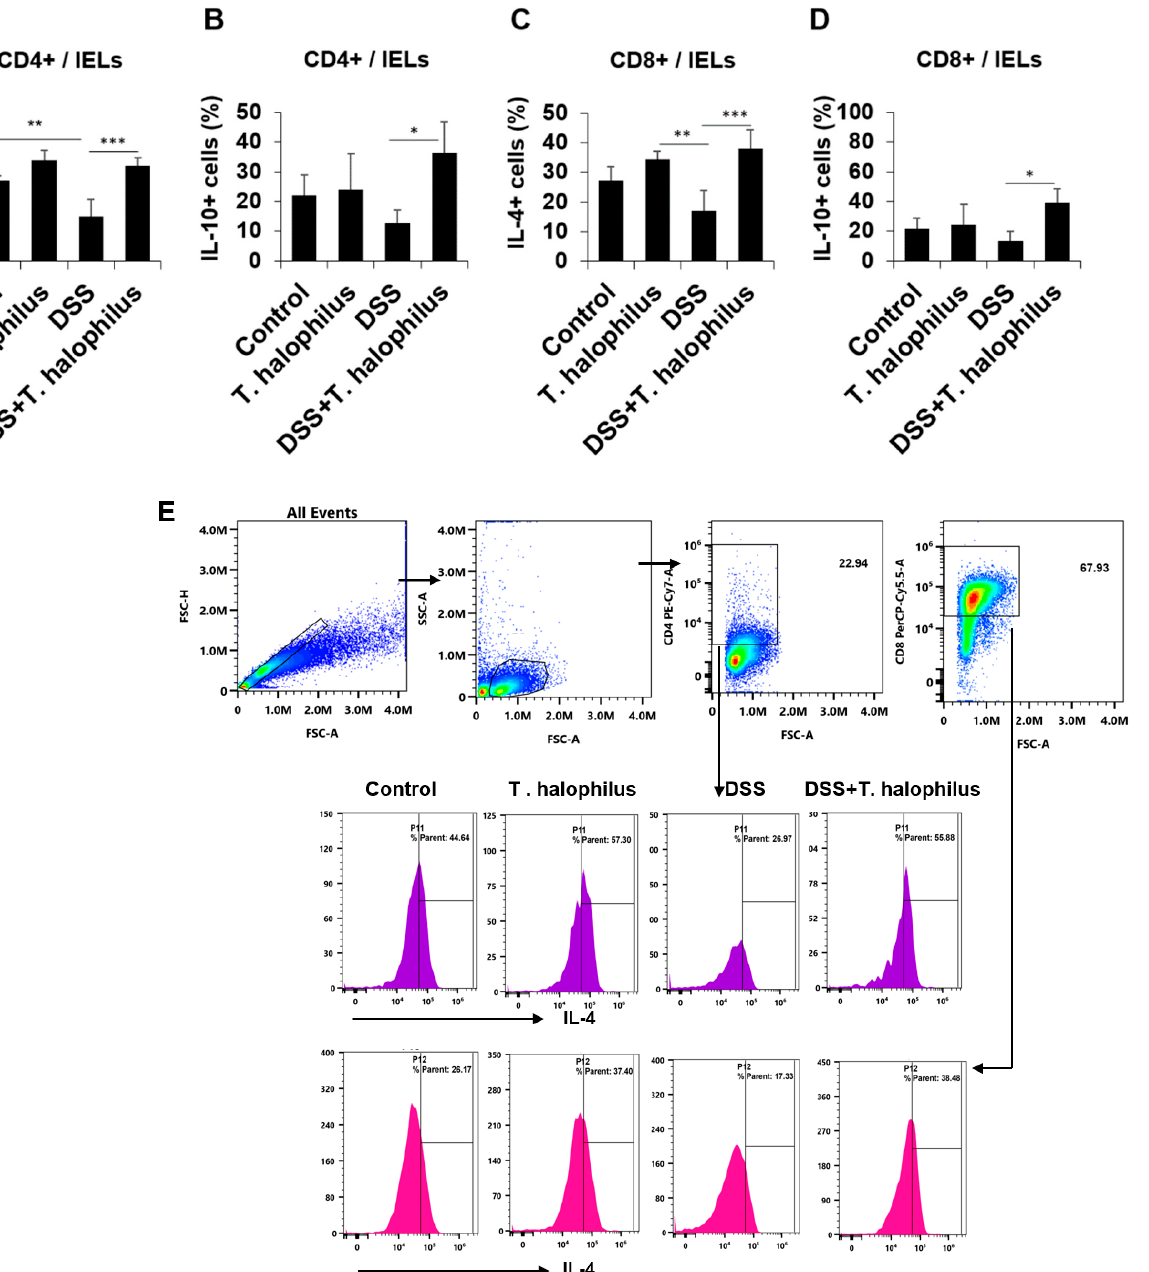
Figure 6. Frequencies of IL-4+ and IL-10+ cells in CD4+ and CD8+ T cells from intestinal epithelial lymphocytes (IELs) of normal control mice, normal mice treated with T. halophilus , DSS-induced colitis mice, and colitis mice treated with T. halophilus were evaluated by flow cytometry analysis ( A – D ). The gating strategy of IL-4 in IELs is shown in ( E ). A one-way ANOVA followed by Bonferroni’s multiple comparison test was performed with GraphPad for statistical analysis. Four mice were used in each experimental group. Experiments were performed in duplicate. Significantly different p- values are indicated with asterisks as follows: *, p < 0.05; **, p < 0.01; ***, p < 0.001.